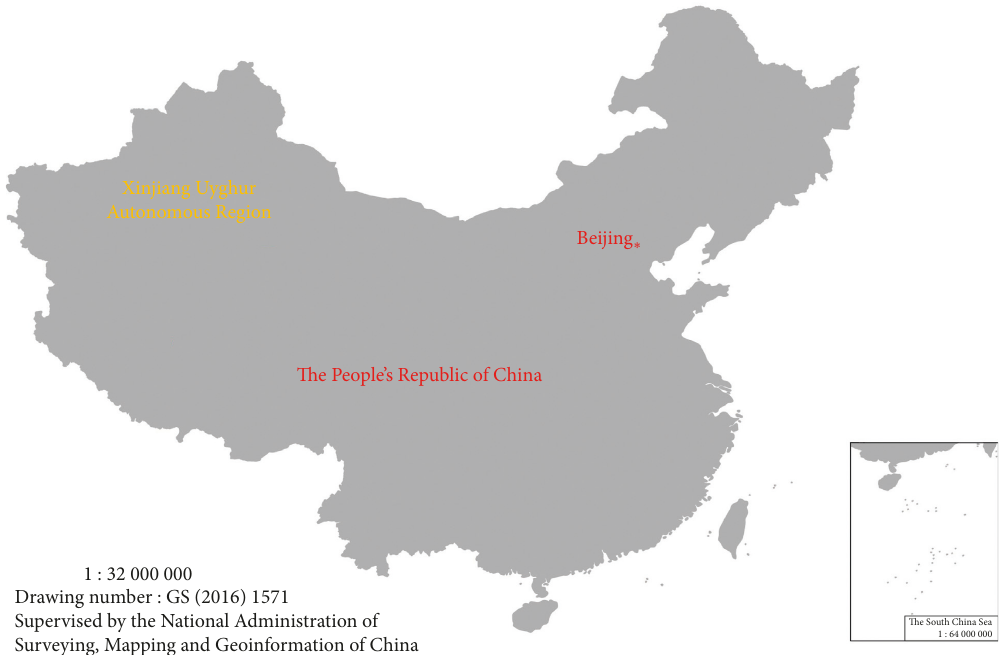
Figure 1: Location of Xinjiang. Source: website of the Chinese National Administration of Surveying, Mapping and